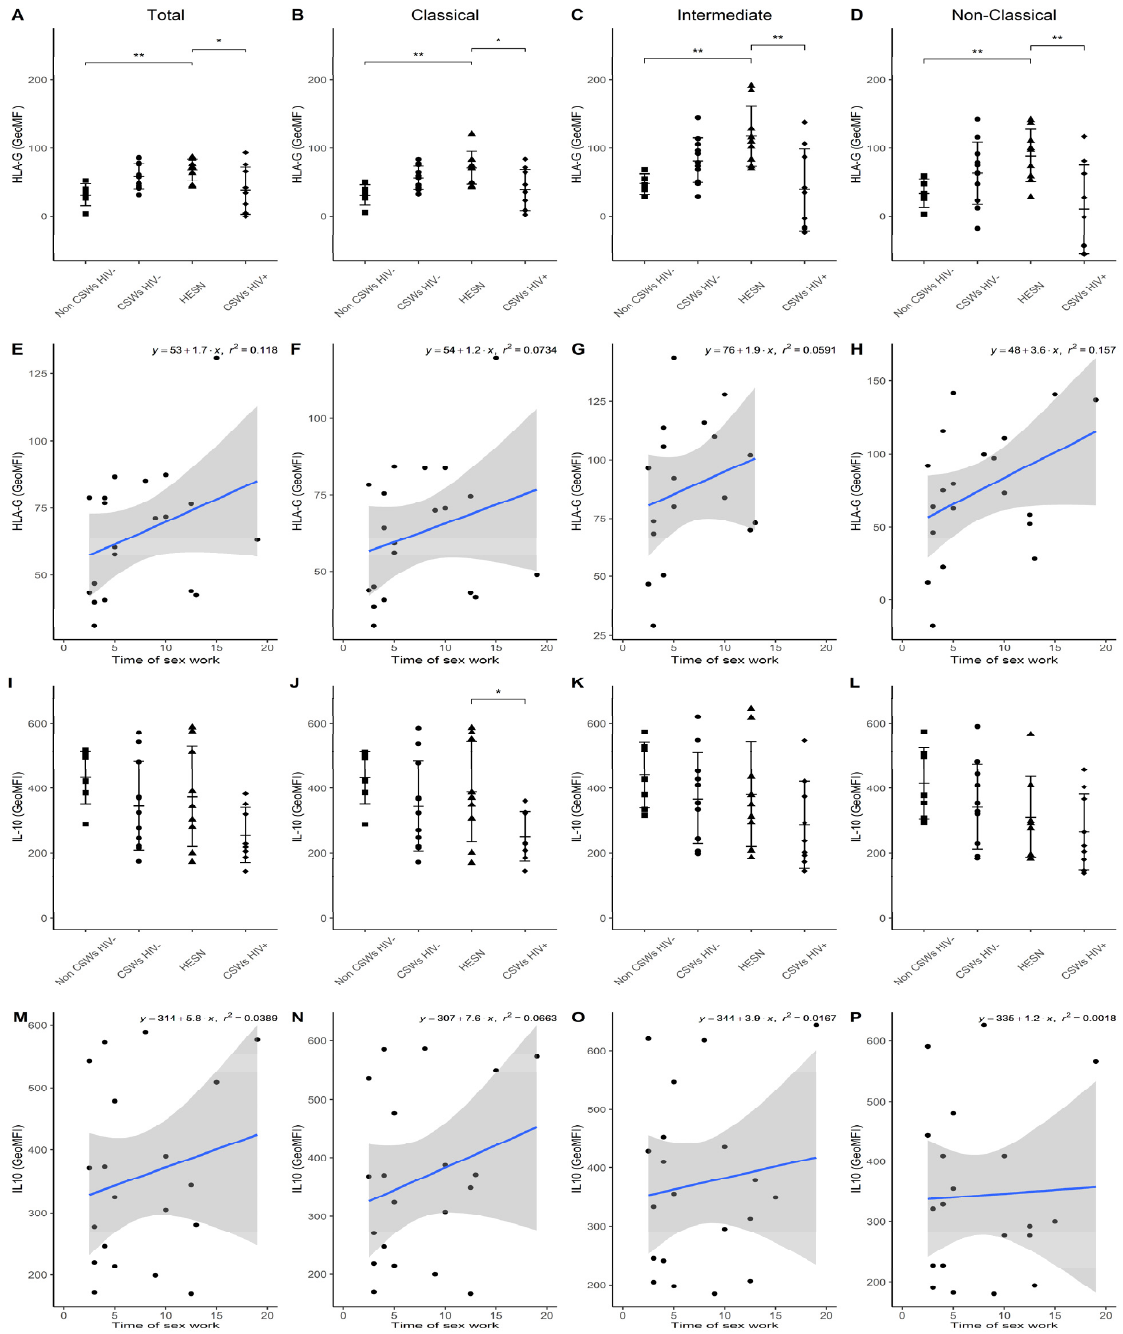
Figure 5. Flow cytometry analyses of HLA-G and IL-10 expression levels by live blood monocyte populations. ( A – D ) Levels of expression of surface HLA-G and ( I – L ) ex vivo IL-10 proteins, as determined by geometric mean fluorescence intensity (GeoMFI), by ( A , I ) CD14 + total, ( B , J ) CD14 + CD16 - classical, ( C , K ) CD14 + CD16 + intermediate, and ( D , L ) CD14 low/dim CD16 ++ non-classical monocytes. Data are presented as the mean value ± SD of samples from 7 non-CSWs HIV- (HIV-1- uninfected control women from the general population), 9 CSWs HIV- (HIV-1-uninfected 2.5-5 years CSWs “early HESNs”), 11 HESNs (HIV-1-uninfected ≥ 10 years CSWs), and 9 CSWs HIV+ (HIV-1-infected CSWs). Significance levels are shown as * ( p < 0.05), ** ( p < 0.01). ( E – H , M – P ) Linear regression analyses are shown for CSWs HIV- (HIV-1-uninfected 2.5–5-year CSWs “early HESNs”) and HESNs (HIV-1-uninfected ≥ 10 years CSWs).